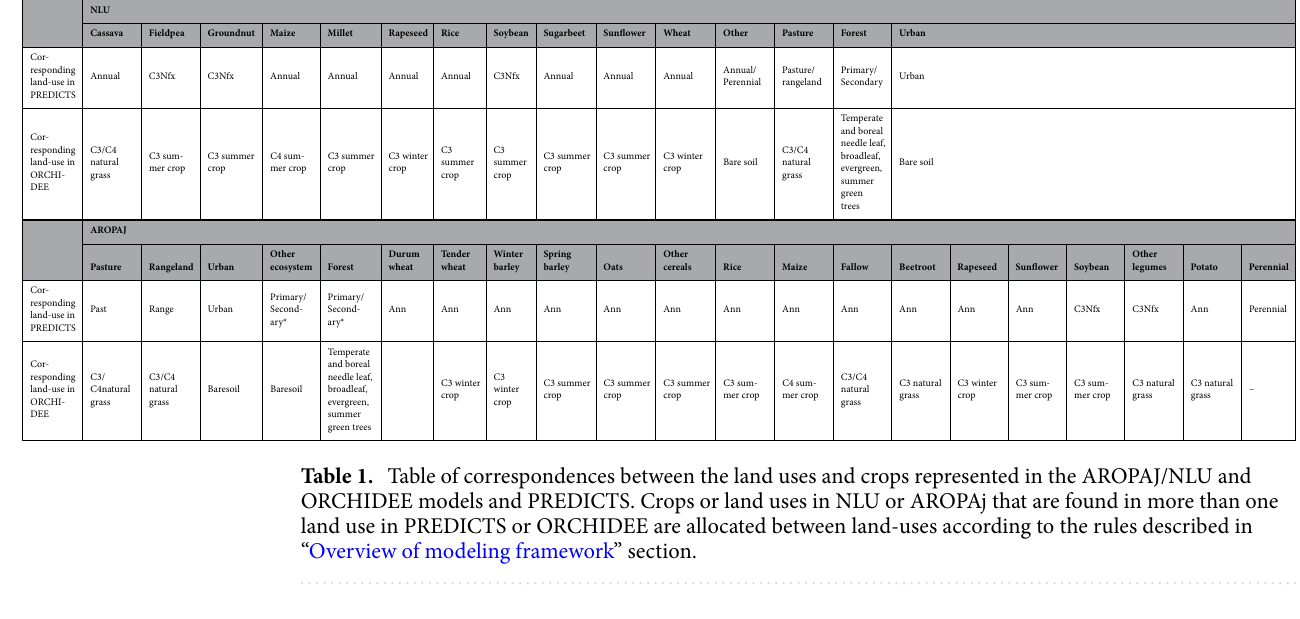
Meteorological forcing (Air temperature, specific humidity, incoming shortwave and longwave radia- tion, rainfall), land use change scenarios, CO 2 , N fertilizers etc.